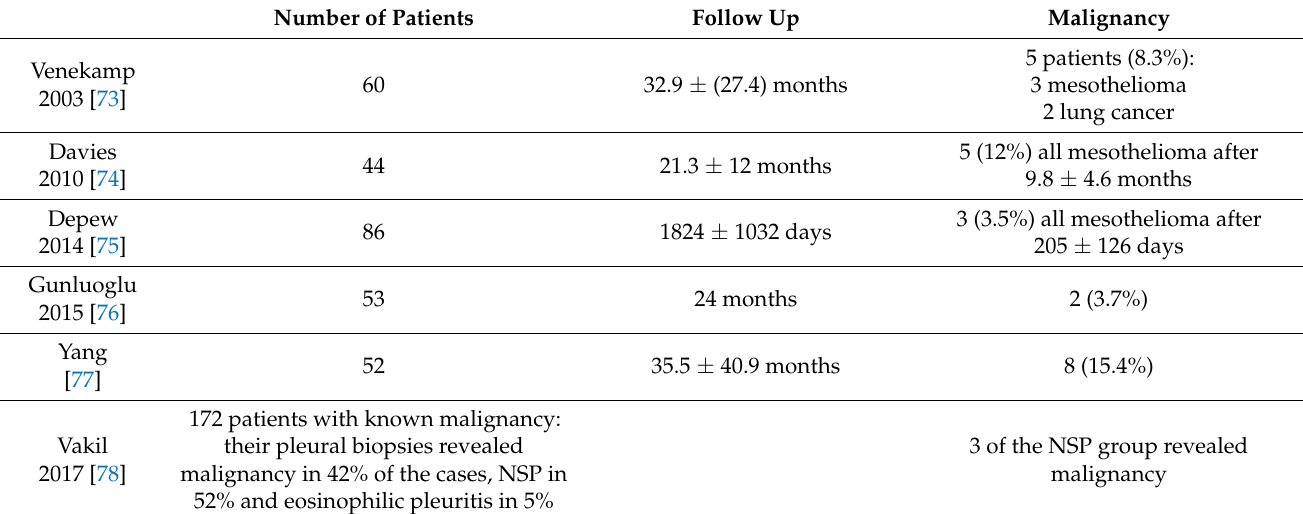
Table 2. Main findings of studies reporting on the follow up of non-specific pleuritis